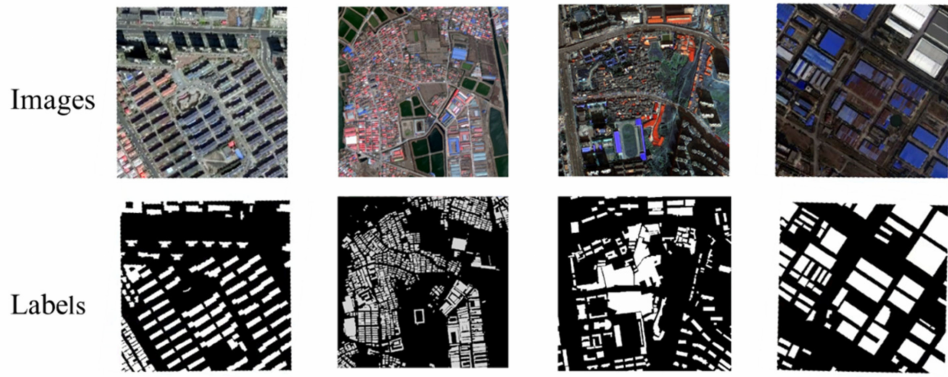
Figure 8. Building samples from GF-2 multispectral fused images for network